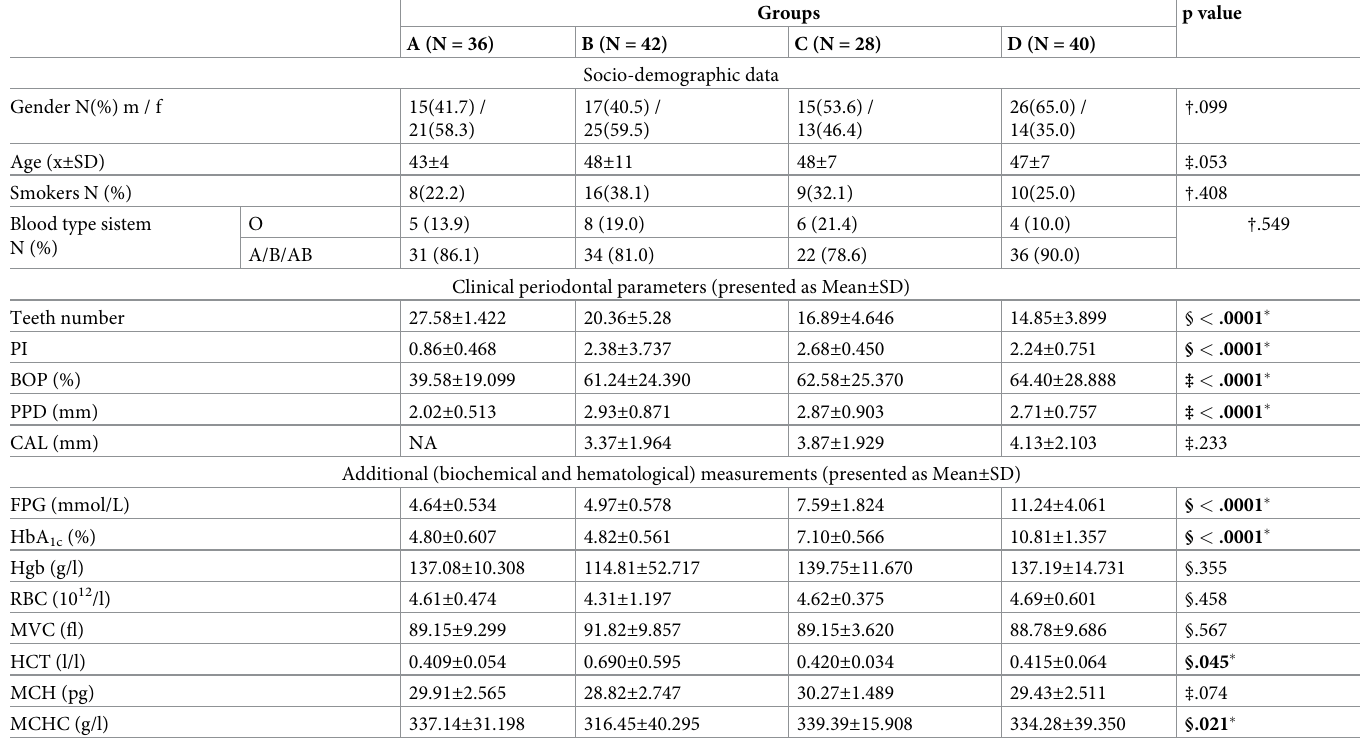
Table 1. Demographic records, blood count and biochemical analysis data in